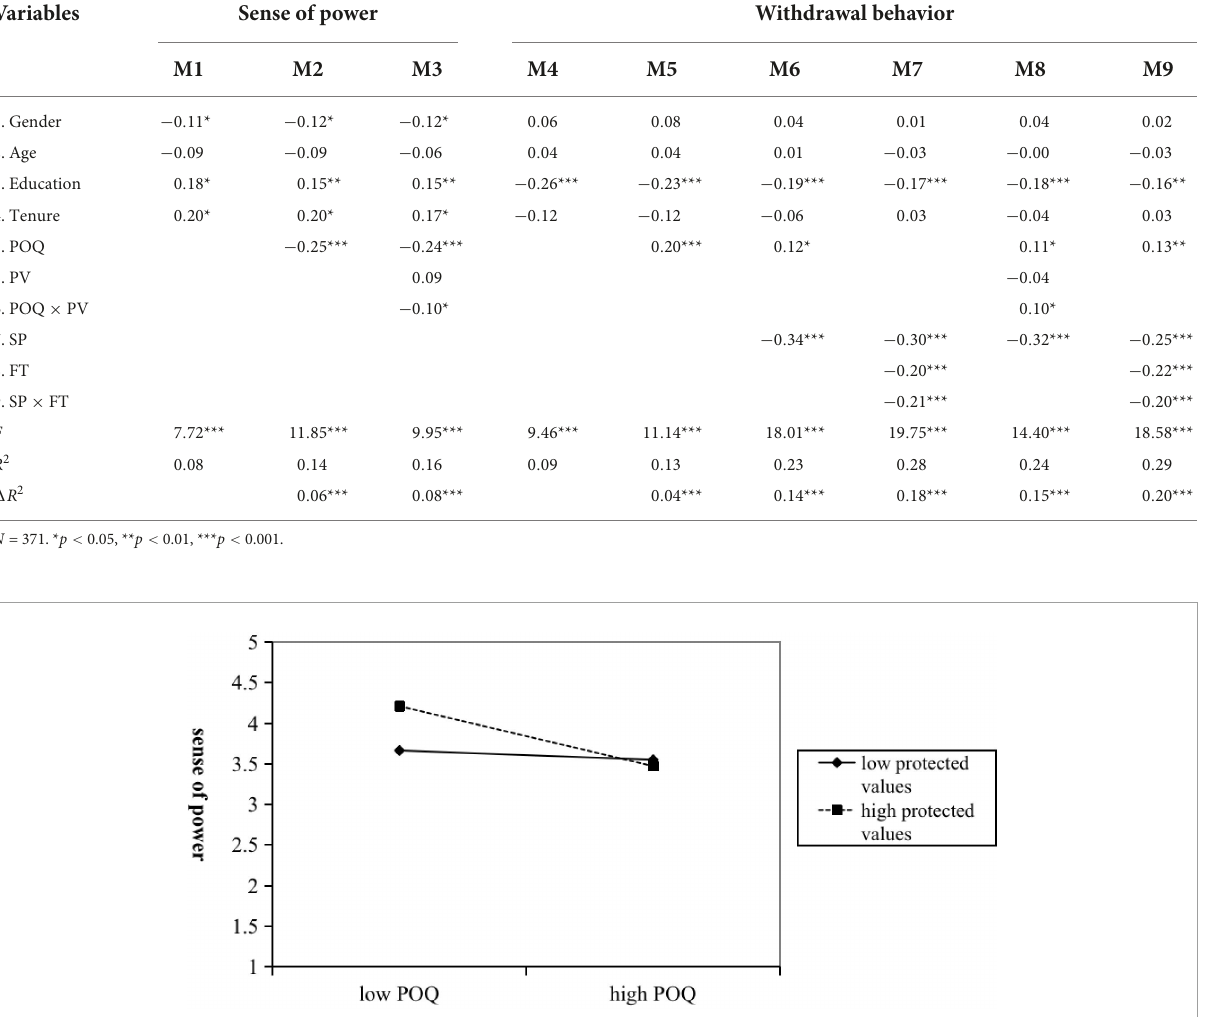
TABLE 3 Hierarchical regression results.